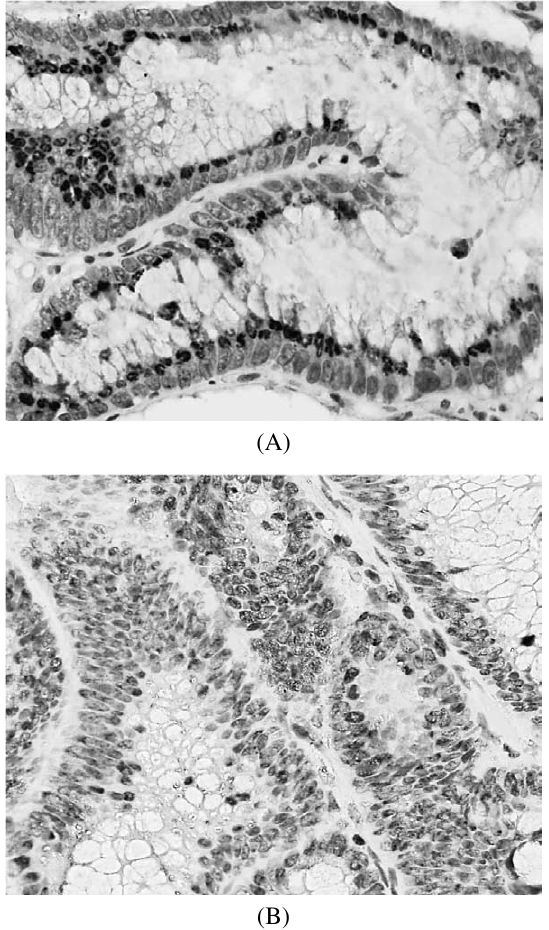
Fig. 4. Different subcellular localization of caspase-8. (A) Paranu- clear localization of caspase-8 in an adenoma. (B) Nuclear localiza- tion of caspase-8 in an